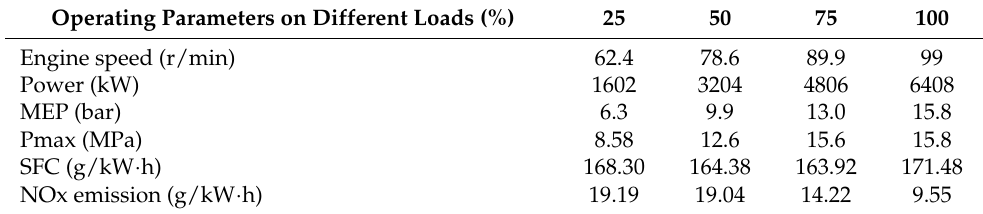
Table 2. Operating parameters on different loads of the test